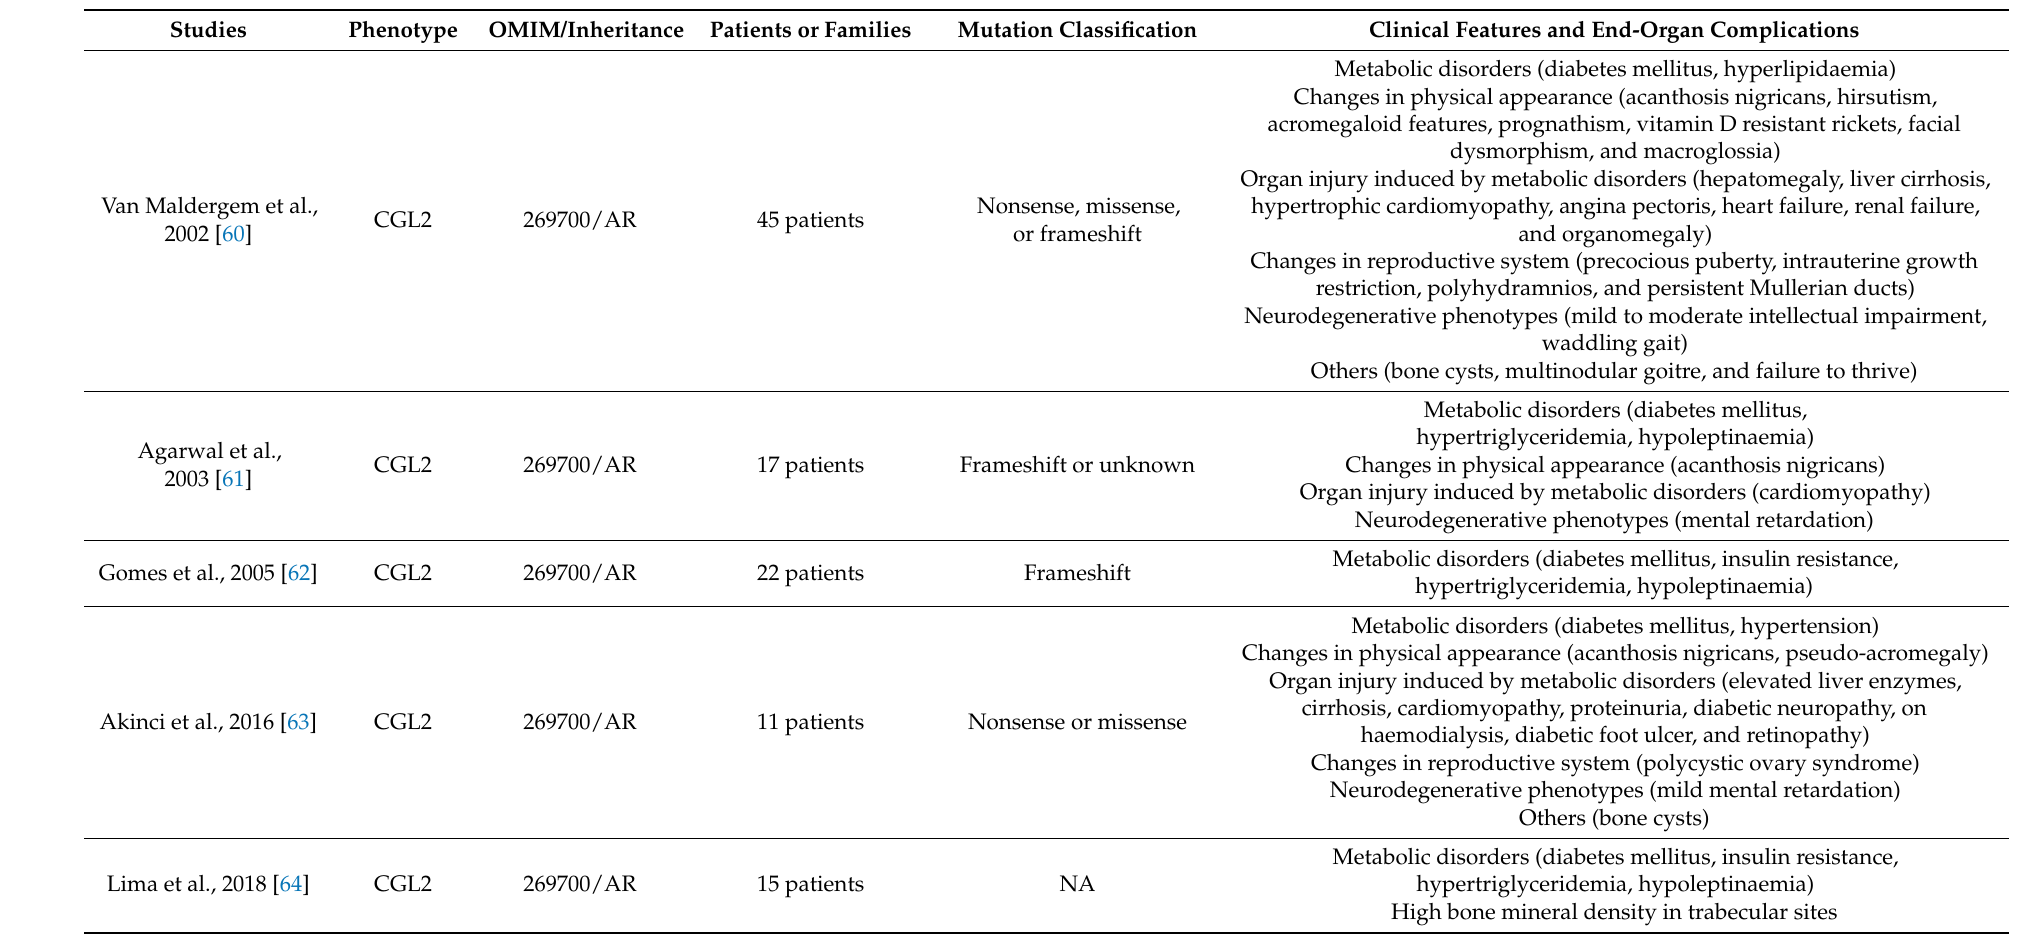
Table 1. Human disease cohorts ( n ≥ 9) caused by BSCL2 gene